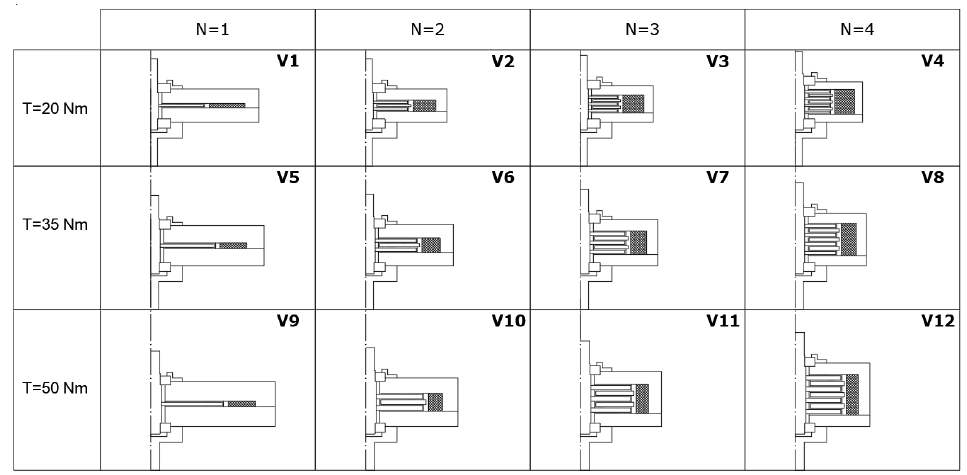
Figure 4. Graphical overview of clutch cross-sections for all 12 designed variants: T c = 20, 35, 50 Nm, N = 1, 2, 3, 4. Table 1. List of design geometrical dimensions and winding data different for 12 individual